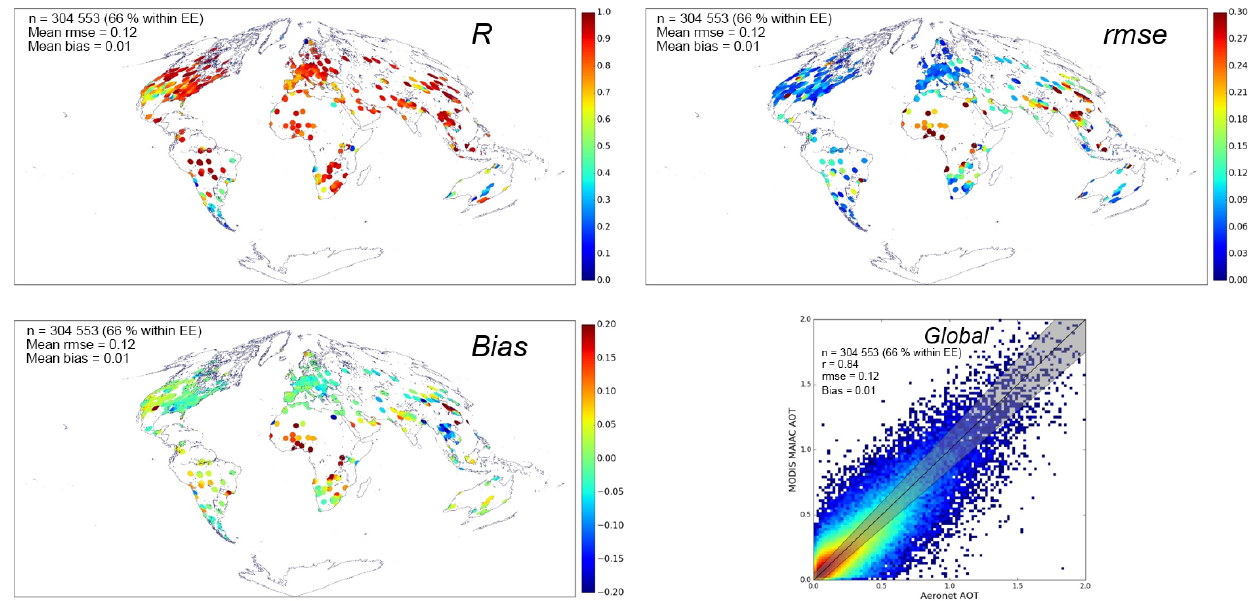
Figure 7. Results of global MAIAC AOD validation against AERONET from the MODIS Terra and Aqua 2000–2016